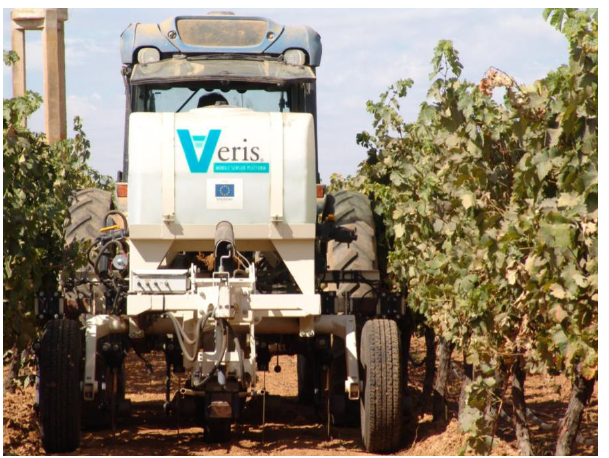
Figure 6. Mobile sensor platform Veris 3150 for ECa mapping (reproduced from [57], with permis- sion from SOIL ,